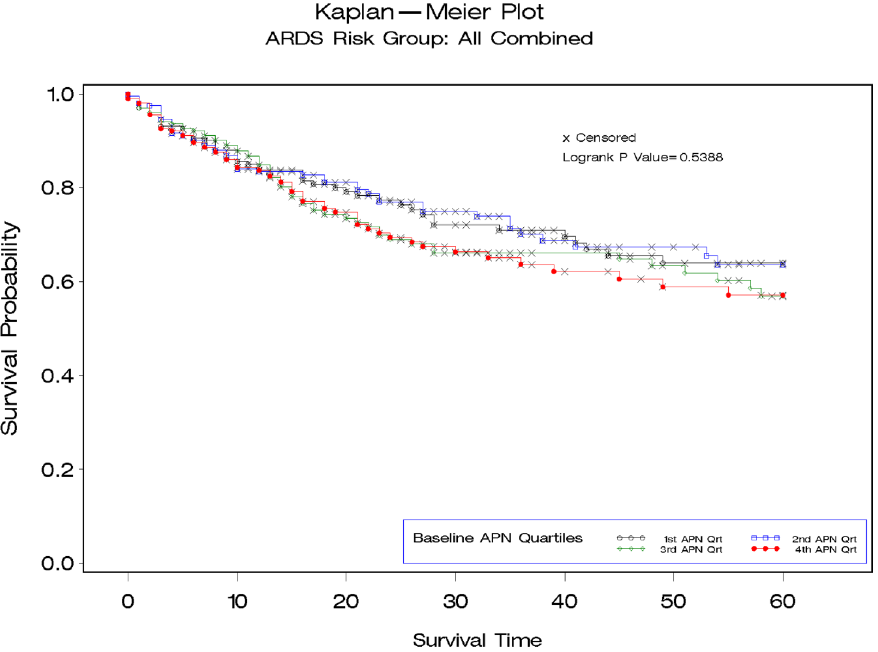
Figure 1. Kaplan-Meier survival plot demonstrating 60-day mortality for patients with acute respiratory distress syndrome stratified by quartile of baseline adiponectin (APN) level for full cohort (N=816). APN Quartile 1: 95–3589 pg/ml; Quartile 2: 3630– 7241 pg/ml; Quartile 3: 7248–13212; Quartile 4: 7248–13212.